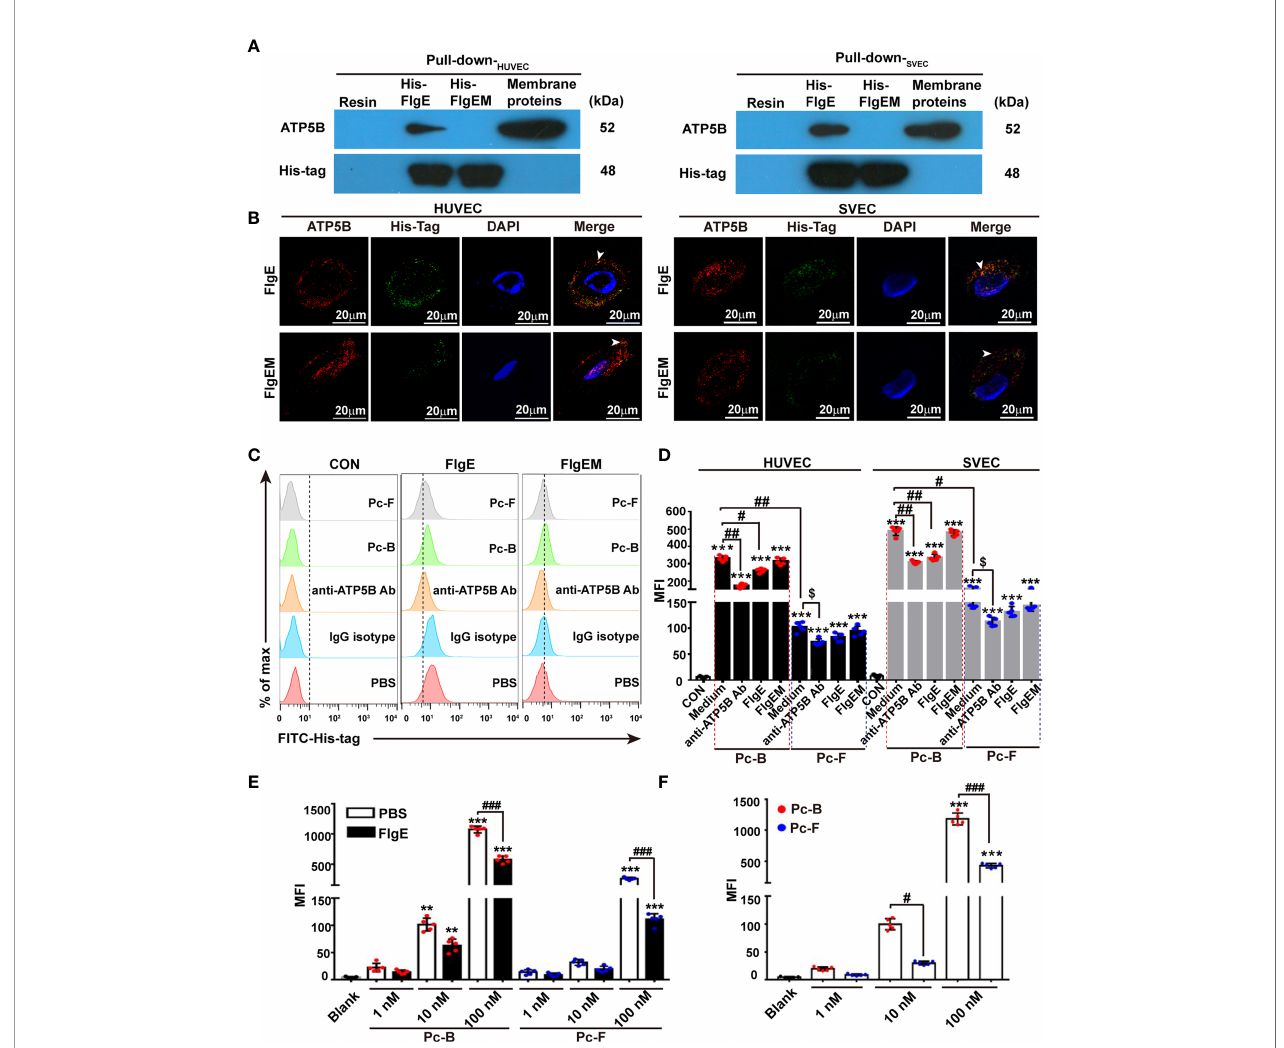
FIGURE 2 | Binding of recombinant FlgE proteins onto ectopic ATP5B on endothelial cells. (A) Pull-down analysis demonstrated af fi nity between recombinant FlgE proteins and ATP5B in membrane lysates prepared from HUVEC or SVECs. Membrane proteins of VECs were incubated with either His-FlgE- or His-FlgEM- conjugated Ni-NTA beads (lanes 2 and 3 from the left) or nude Ni-NTA resin beads (far left lanes), and recovered proteins from the beads were subjected to routine immunoblotting with anti-ATP5B antibodies or anti-6× His-tag antibodies. Equivalent amount of starting membrane lysates was run at side as positive control of ATP5B proteins (far right lanes). (B) Surface localization of FlgE/FlgEM and ectoATP5B on HUVECs and SVECs. HUVECs and SVECs grown on glass coverslip were incubated with FlgE (10 m g/ml) and anti-ATP5B antibodies (50 m g/ml) for 1 h The cells were fi xed with 4% PFA and blocked with 3% BSA. FlgE was stained with primary mouse anti-6× His-tag antibodies and FITC-anti-mouse IgG (green). EctoATP5B was stained via PE-anti-rabbit IgG (red). White arrowheads pointed at colocalization of FlgE and ectoATP5B on HUVECs and SVECs. (C) FlgE binding to VECs was inhibited by anti-ATP5B antibodies or Pc-B/Pc-F peptides. HUVEC and SVECs were preincubated for 1 h with anti-ATP5B antibodies (50 m g/ml), isotype IgG, or Pc-B/Pc-F peptides (50 m M) followed by incubation with 10 m g/ml of His-FlgE or His-FlgEM for 40 min. Then the cells were stained with FITC-conjugated anti-6× His antibodies (0.6 m g/ml) and measured by fl ow cytometry. (D) Binding Pc-B/Pc-F peptides on VECs were inhibited by competitive anti-ATP5B antibodies or recombinant FlgE proteins. HUVECs and SVECs were treated with either anti- ATP5B antibodies (50 m g/ml) or FlgE (10 m g/ml), followed by addition of FITC-Pc-B or FITC-Pc-F peptides (50 m M) and sampling in a fl ow cytometer. Mean fl uorescence intensity (MFI) was calculated for all cells. *** p < 0.001 vs . CON. # p < 0.05, ## p < 0.01 vs . Pc-B. $ p < 0.05 vs . Pc-F alone without antibody. (E) Binding of Pc-B/Pc-F peptides on membrane ATP5B proteins was dose-dependent and inhibited by recombinant FlgE proteins. Luminescence test plates were coated with anti-ATP5B antibodies (1 m g/ml) at 4°C overnight, followed by incubation with plasma membrane proteins (5 m g/100 m l, obtained from HUVECs). After blocking with 10 m g/100 m l of FlgE or not (PBS), FITC-Pc-B or FITC-Pc-F peptides were added into the wells to indicate concentrations. After incubation at 37°C for 40 min and three washes, the plates were read for fl uorescence intensity. ** p < 0.01, *** p < 0.001 vs . Blank. ### p < 0.001 vs . PBS. (F) ELISA of FITC-Pc-B and FITC-Pc-F peptides binding to ATP5B analog rATP5BesT. rATP5BesT proteins were used to coat ELISA plates at 5 m g/ml overnight, FITC-Pc-B and FITC-Pc-F peptides were added to different concentrations, and bound peptides were measured as above. *** p < 0.001 vs . Blank. # p < 0.05, ### p < 0.001 vs . Pc-B. Representative results of three repeats are exhibited. Individual data are shown as dots, while mean ± SD as columns with bars. Two-way ANOVA was performed for statistical comparison. HUVECs, human umbilical vein endothelial cells; SVECs, SV40-transformed endothelial cells of mouse; VECs, vascular endothelial cells; FlgEM, mutant FlgE; PFA, paraformaldehyde; BSA, bovine serum albumin; FITC, fl uorescein isothiocyanate; PE, phycoerythrin; PBS, phosphate-buffered